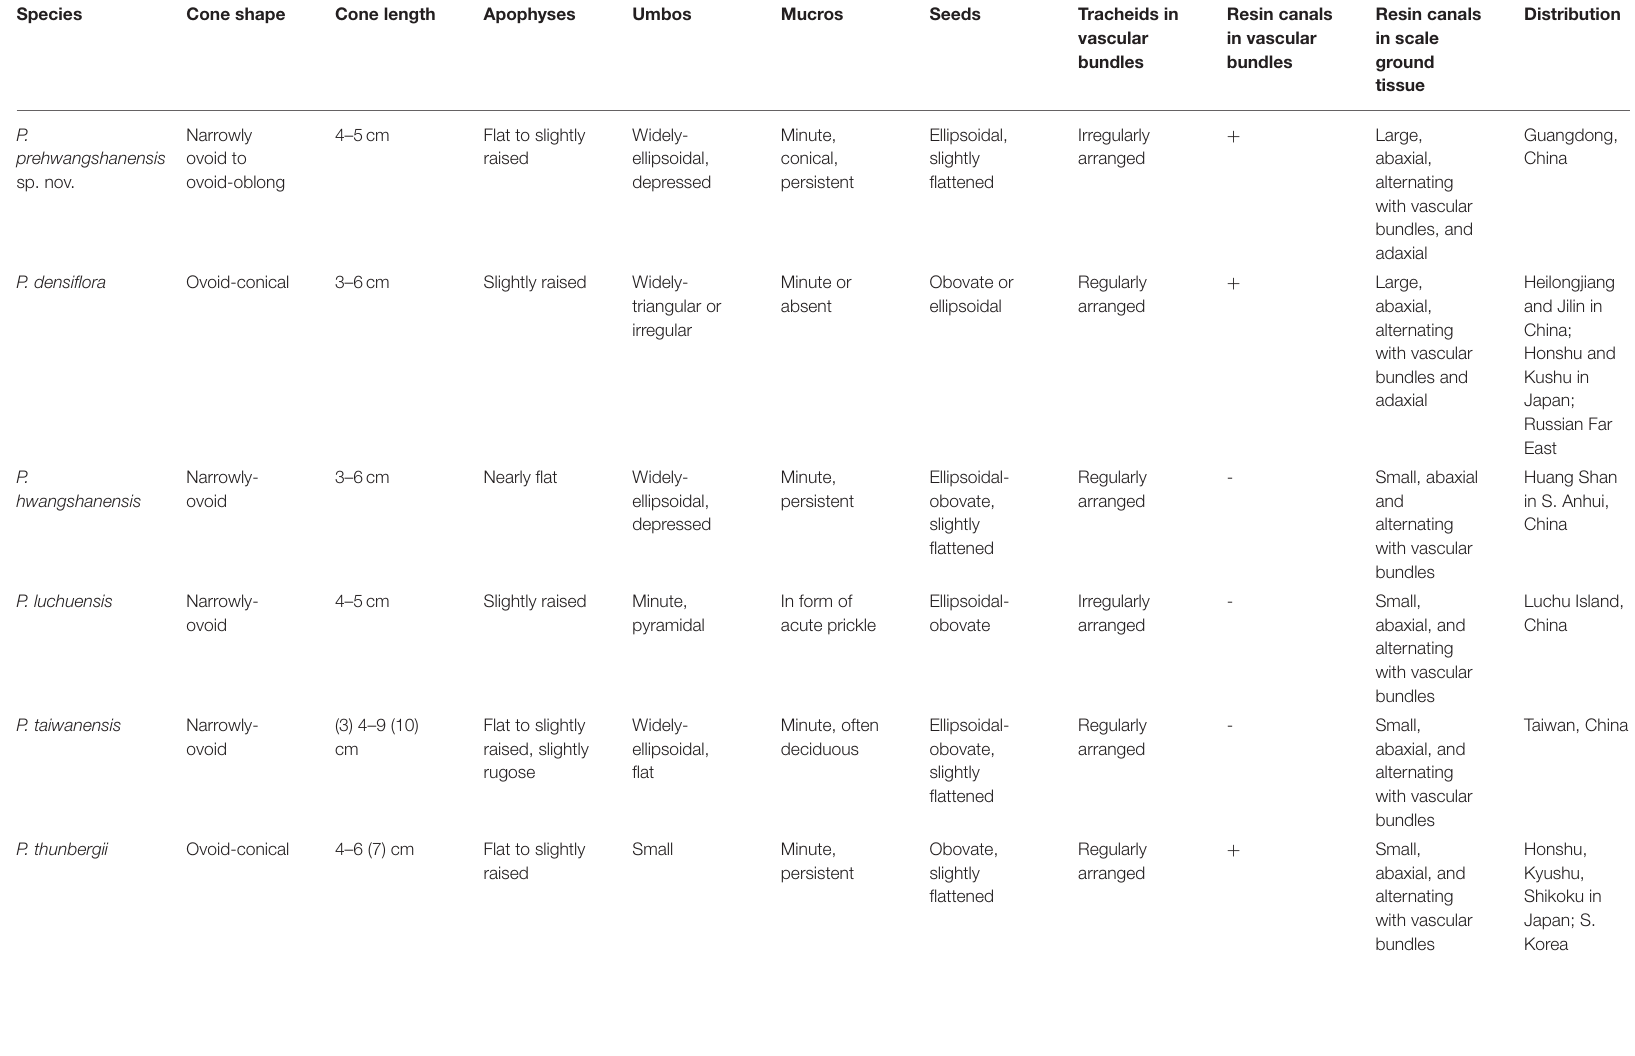
TABLE 1 | Comparison of the seed cones of Pinus prehwangchanensis sp. nov. and related extant species of Pinus .